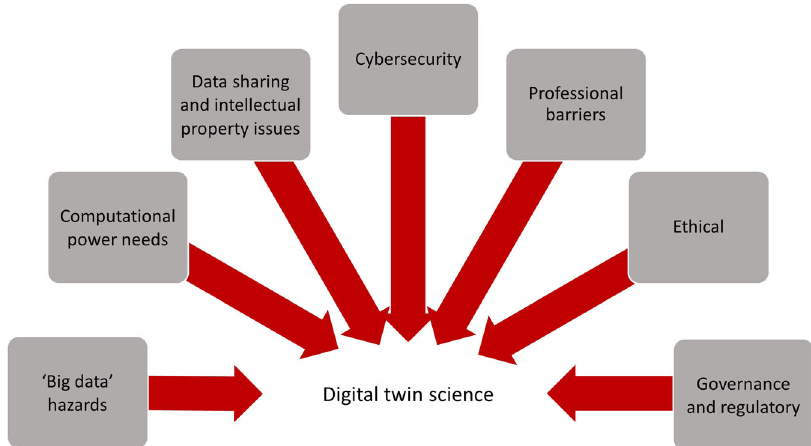
Fig. 4 Translation issues in digital twin